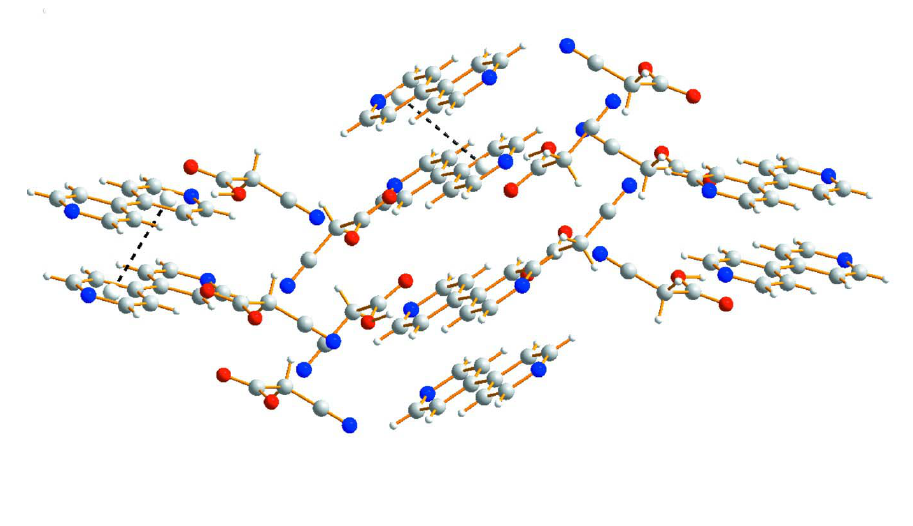
A view of the three-dimensional hydrogen-bonding pattern network.